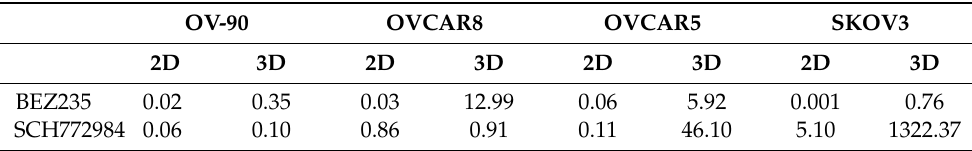
Table 1. Table of EC 50 ( µ M) values for the two inhibitors, BEZ235 and SCH772984, against OV-90, OVCAR8, OVCAR5 and SKOV3 monolayers (2D) and aggregates